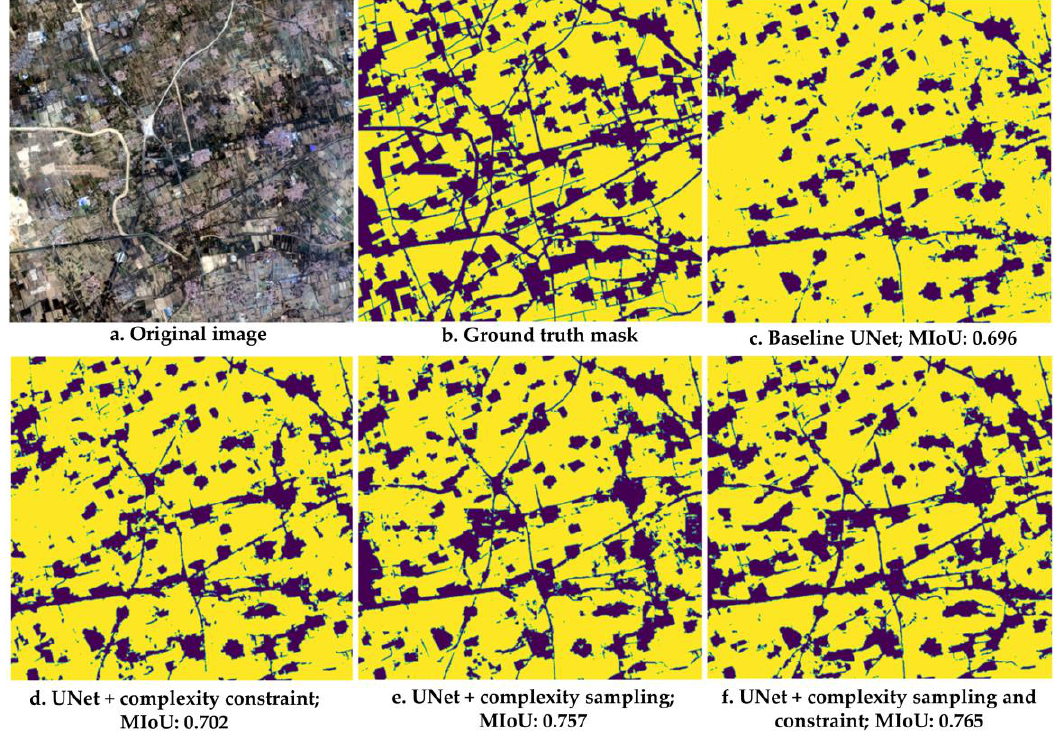
Figure 10. Comparison between farmland segmentation results of baseline UNet, UNets with complexity-informed constraint/sampling, and UNet with both. ( a ) shows the RGB images depicting true colors; ( b – f ) display yellow masks representing the farmland feature for ground truth ( b ) or predictions ( c – f